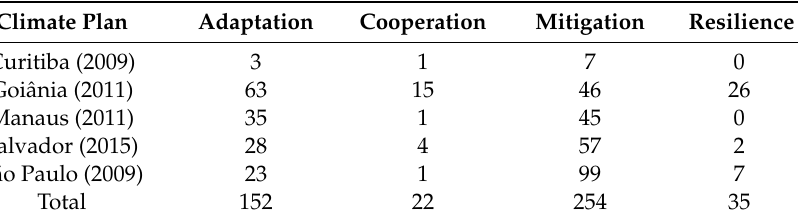
Table 6. Climate action references in local climate plans.